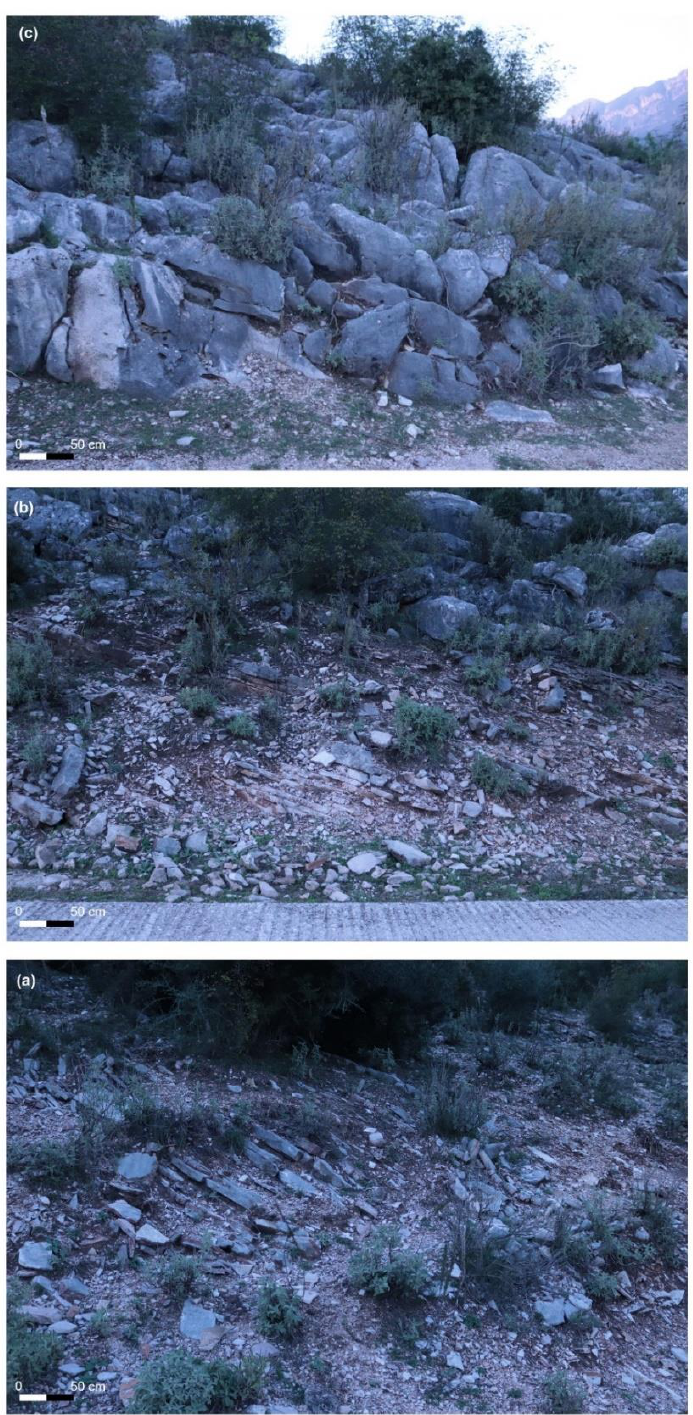
Figure 4. Outcrop images showing the different parts of Gardiki section corresponding to the Cretaceous–Paleogene transition. ( a ) Alterations of thin-to-medium-bedded limestones and cherts of Late Maastrichtian age, ( b ) Thin-bedded pelagic limestones corresponding to the K-Pg boundary, ( c ) Massive bioclastic limestone succession of early Paleocene age.